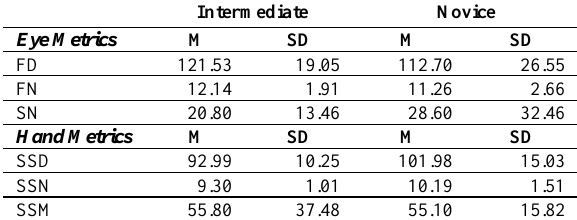
Table 3. Descriptive Results for the Metrics in